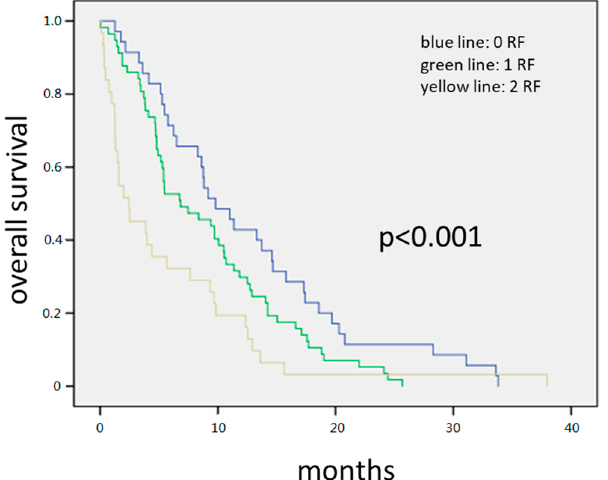
Figure 2. The 145 patients with complete data available for all variables. Forty-five patients had none of the above-mentioned risk factors, 65 patients had one, and 35 had both risk factors. The median OS for all patients was 8.3 months. Patients with zero risk factors had 11.3 months compared to 7.1 months with one and 3.8 months with two risk factors, respectively. Survival differences among groups were statistically significant (HR = 1.558; 95% CI = (1.26–1.95); p < 0.001).